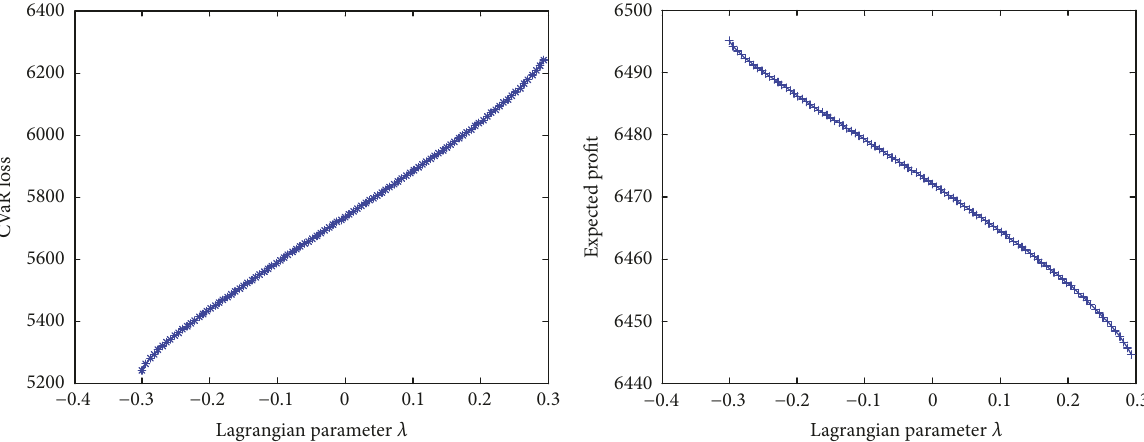
Figure 2: CVaR and the expected profit under different 𝜆 ∈ (𝜆, 𝜆] .